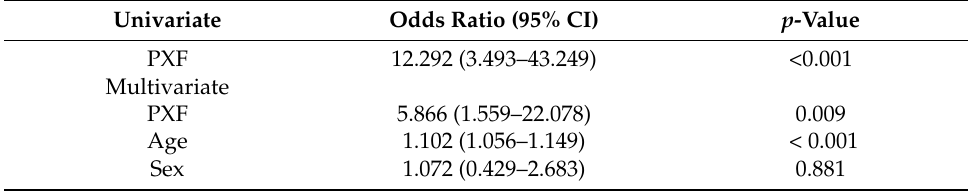
Table 6. PXF association with